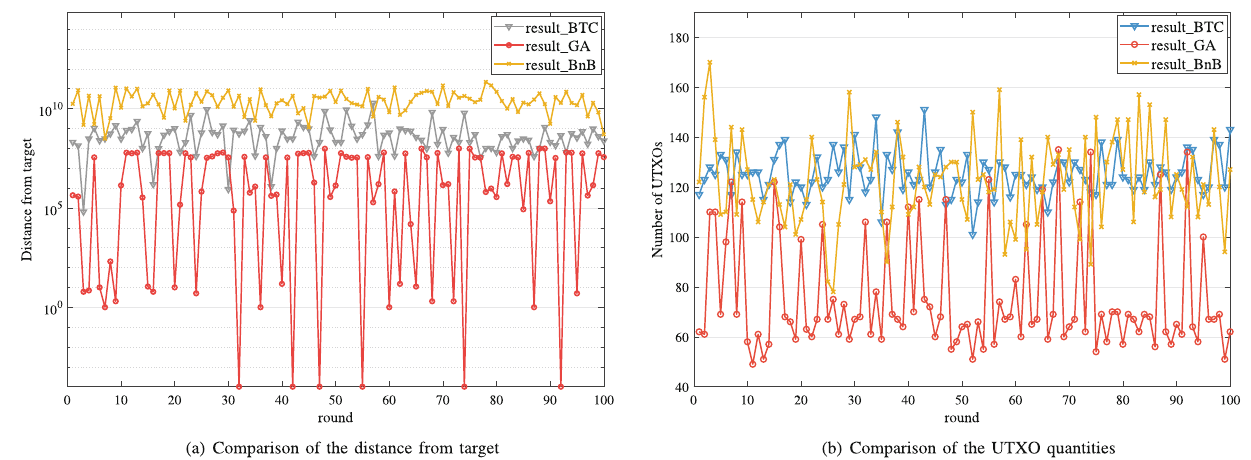
Fig. 10 Comparison of 100 rounds results in real bitcoin account (bitcoin